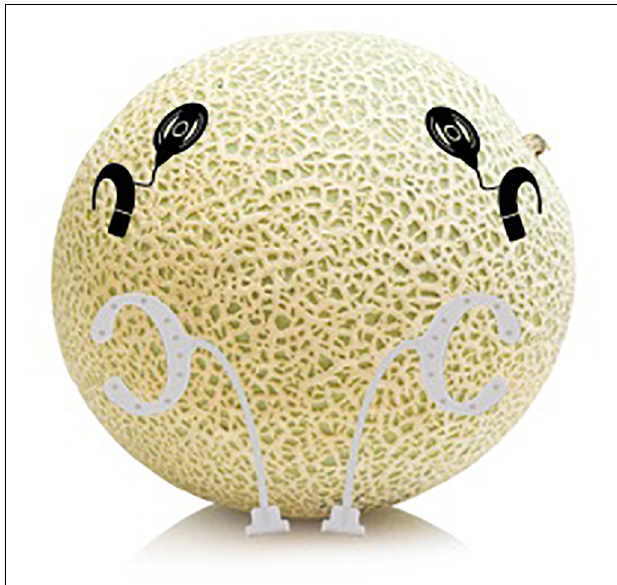
FIGURE 4 | Schematic illustration of the experimental setup to investigate the influence of the cochlear implant (CI) artifact on the decoding accuracy.